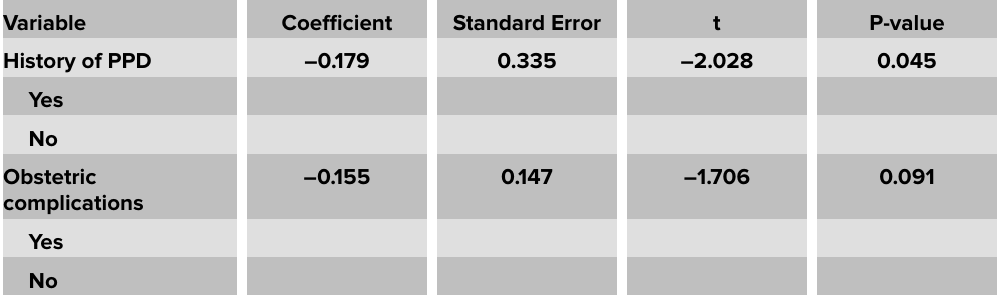
TABLE 3: Results of the multiple linear regression on factors associated with EPDS scores; n =